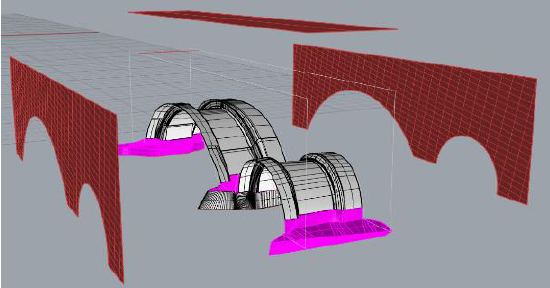
Figure 9. Construction of the structural parts of the bridge: containment walls, vaults and